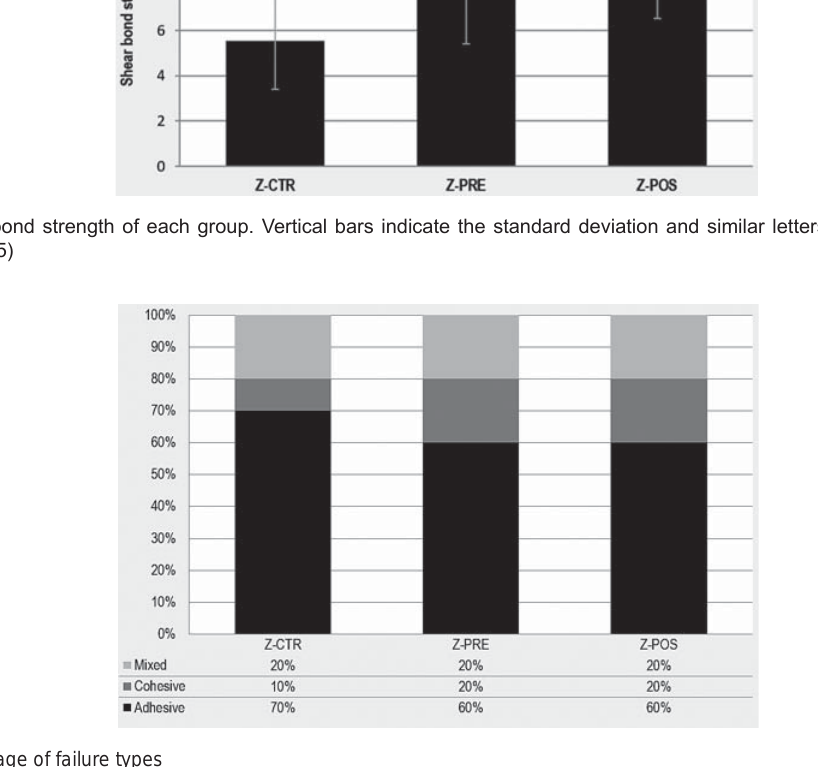
Figure 5- Percentage of failure